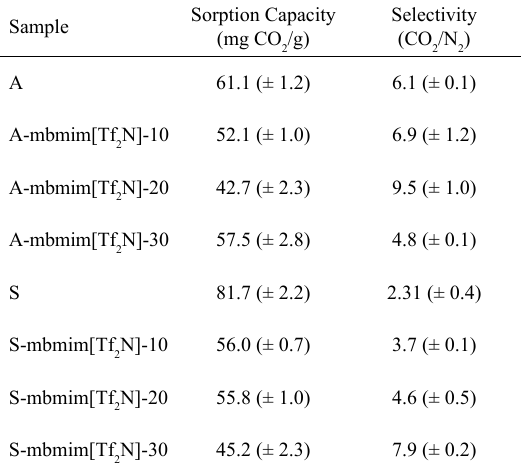
sorption capacity and CO Table 3. CO 2 S and A with and without IL